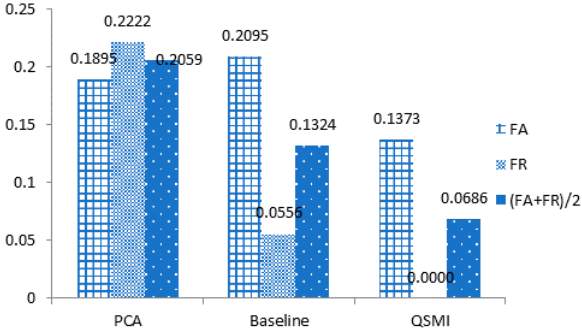
Figure 12. Comparison of ECG two-lead algorithms.